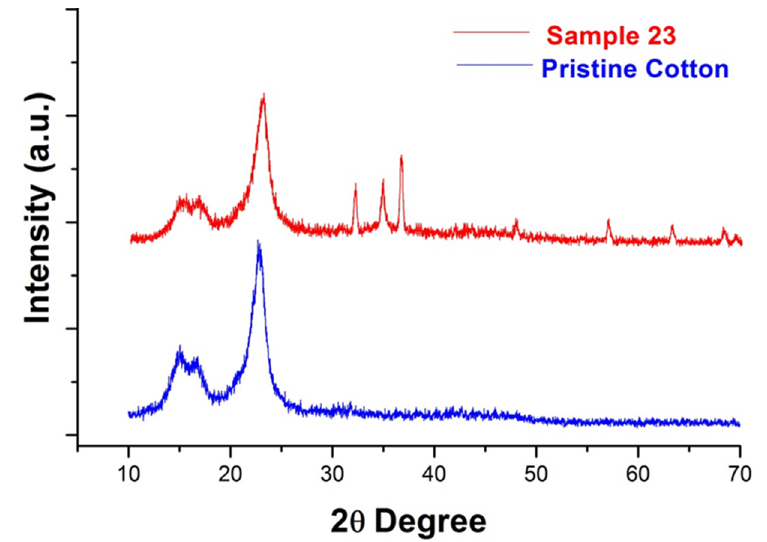
Figure 4. XRD diffractogram of pristine cotton and sample 23.